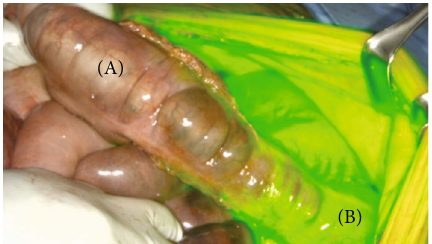
Figure 2: Indocyanine green perfusion to edge of small bowel mesentery but not beyond; no perfusion is present to the small bowel serosa.